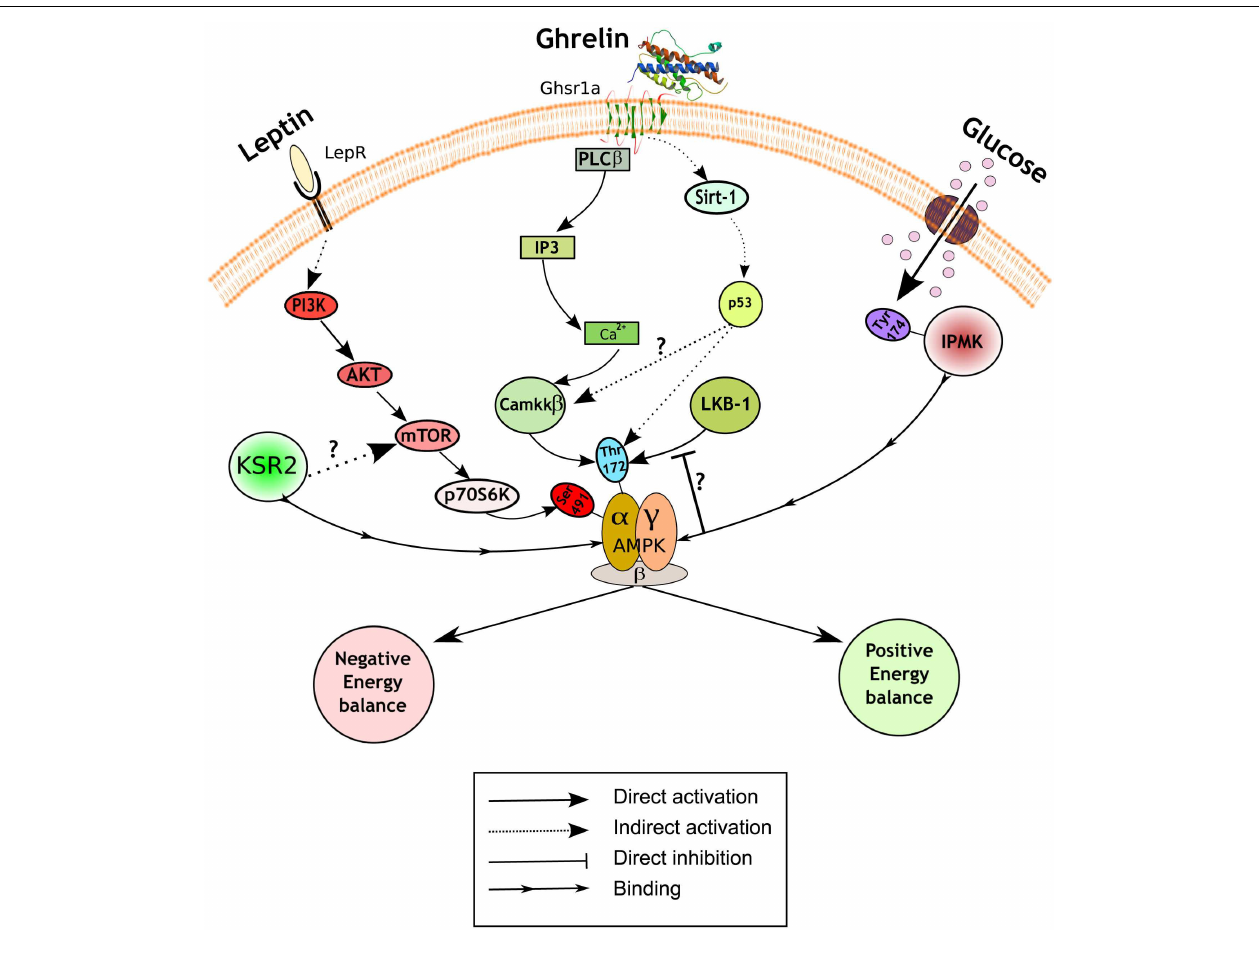
FIGURE 1 | HypothalamicAMPK regulates appetite. Schematic representation of a generic hypothalamic neuron depicting a summary